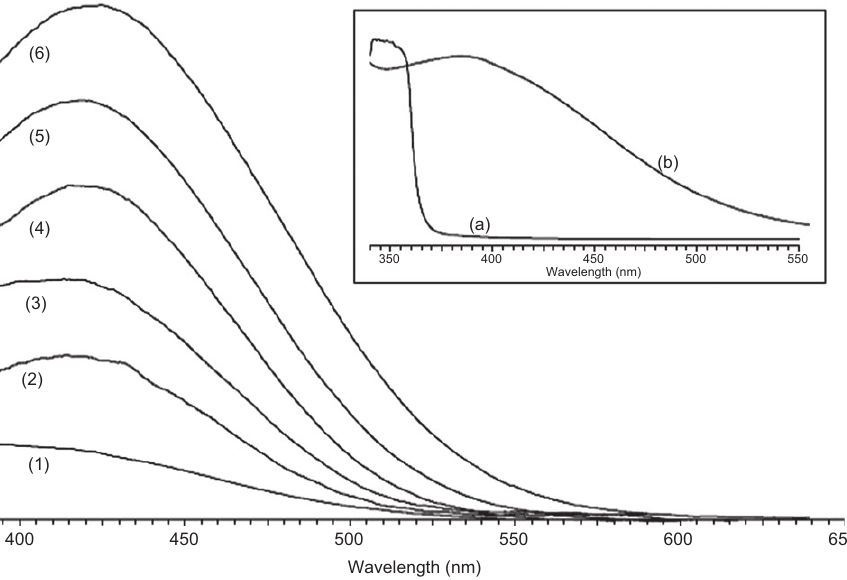
Figure 3 Absorption spectra of the yellow reaction product at different concentrations of nitrate in mg l -1 [(1) 0.51, (2) 1.55, (3) 3.10, (4) 6.25, (5) 9.3, and (6) 10.85], recorded against a blank solution. Inside – the absorption spectra of chromotropic acid (a) and reaction product (b) recorded against double distilled water.